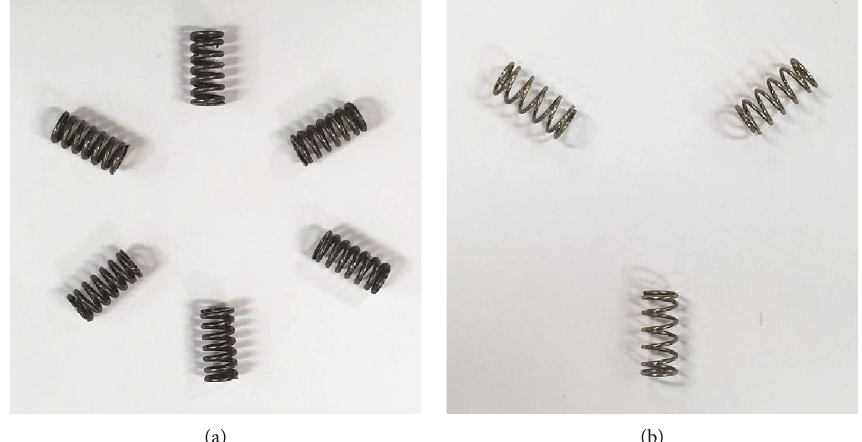
Figure 9: Visual inspection results of coil-springs of PLOVIS-II after launch vibration tests ((a) high-sti ff ness coil-springs, (b) low-sti ff ness coil-springs).